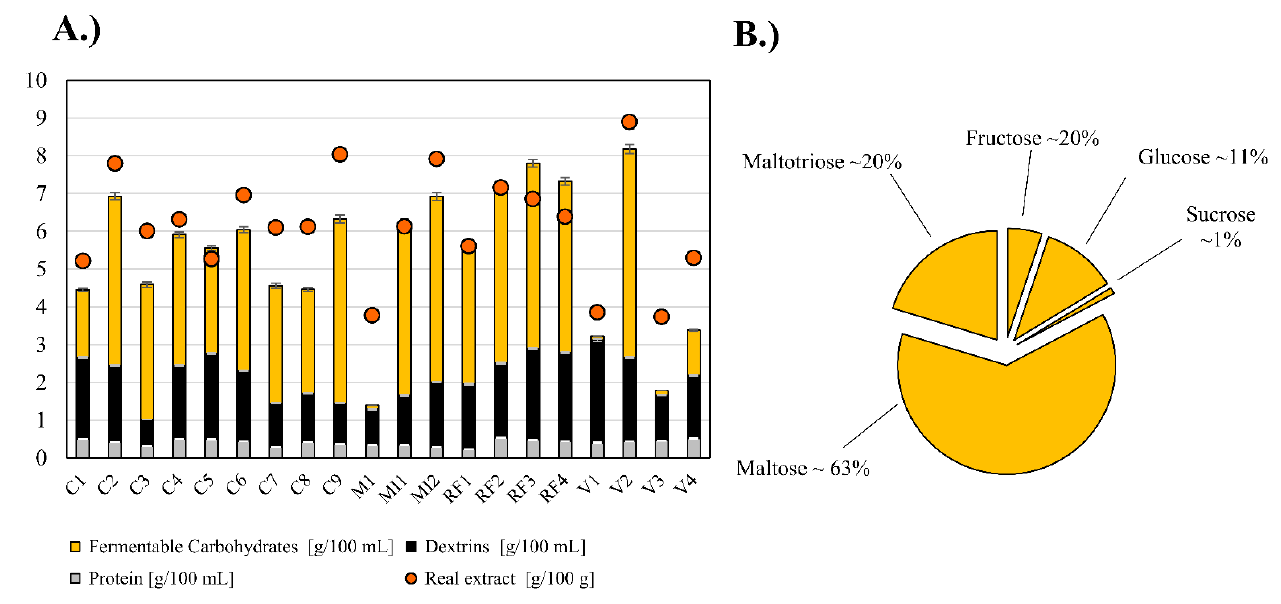
Figure 1. ( A ) The composition of protein, dextrins. and fermentable carbohydrates and their relation- ship to residual extract. ( B ) The average percentage for each individual fermentable carbohydrate (i.e., maltose, maltotriose, fructose, sucrose, and glucose) contribute to the total fermentable carbohydrate profile amongst the different NABs. Error bars are calculated for each measurement and represent 2 × the reported %RSD.